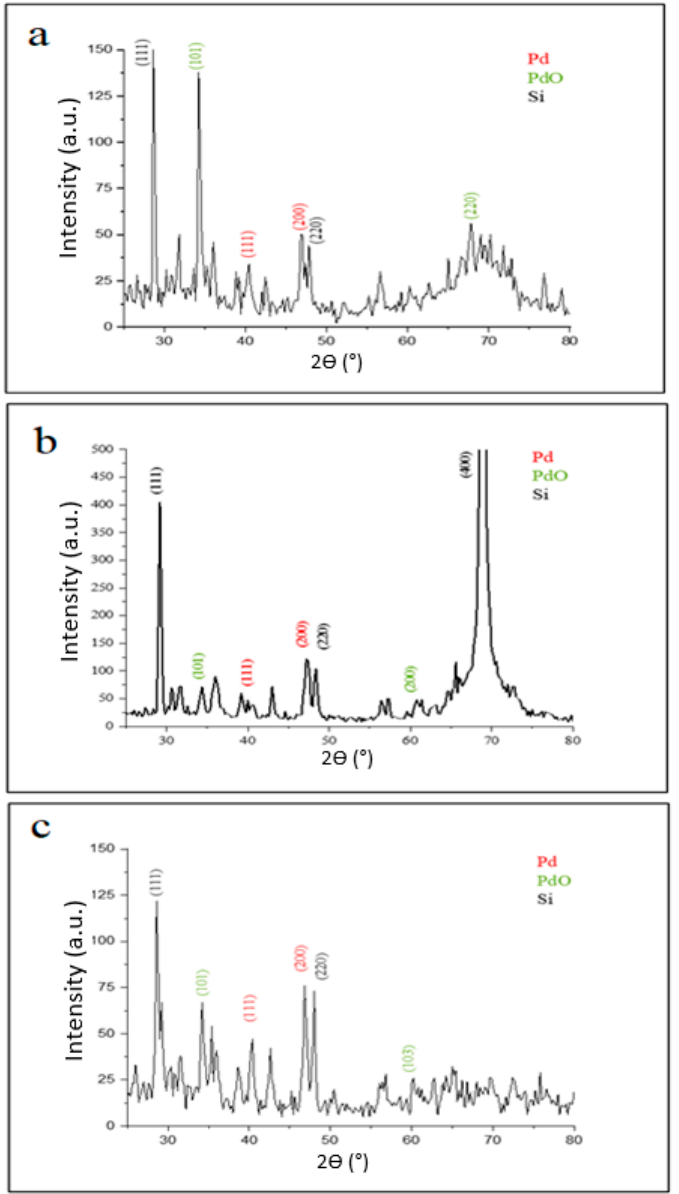
Figure 2. XRD patterns of palladium nanoparticles (Pd NPs) prepared by pulsed laser ablation of palladium target in distilled water with different laser fluences of ( a ) 2.04 J/cm 2 , ( b ) 6.12 J/cm 2 , and ( c ) 10.2 J/cm 2 . Table 1. The crystalline size (CS) of palladium nanoparticles (Pd NPs) prepared by 1064 nm laser ablation of palladium target in distilled water with different fluences 2.04 J/cm 2 , 6.12 J/cm 2 , and 10.2) J/cm 2 at 100 pulses.